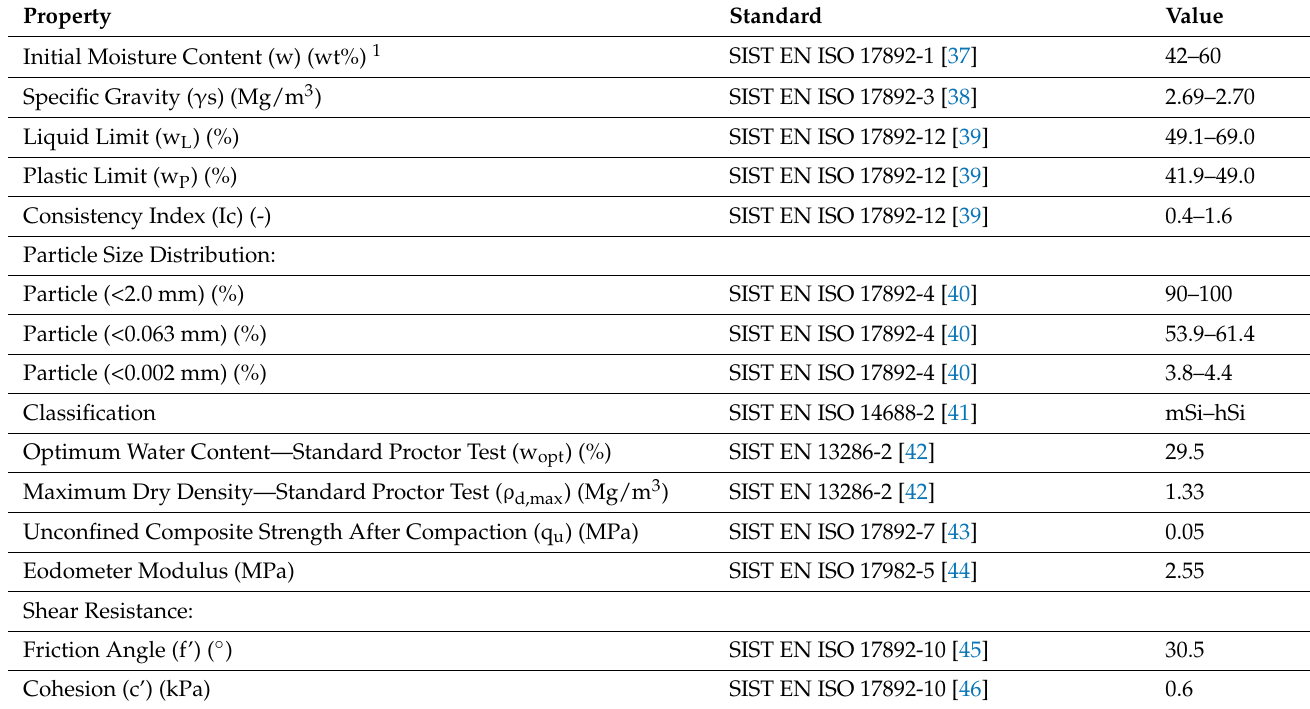
Table 5. Physical and mechanical properties of the naturally dried